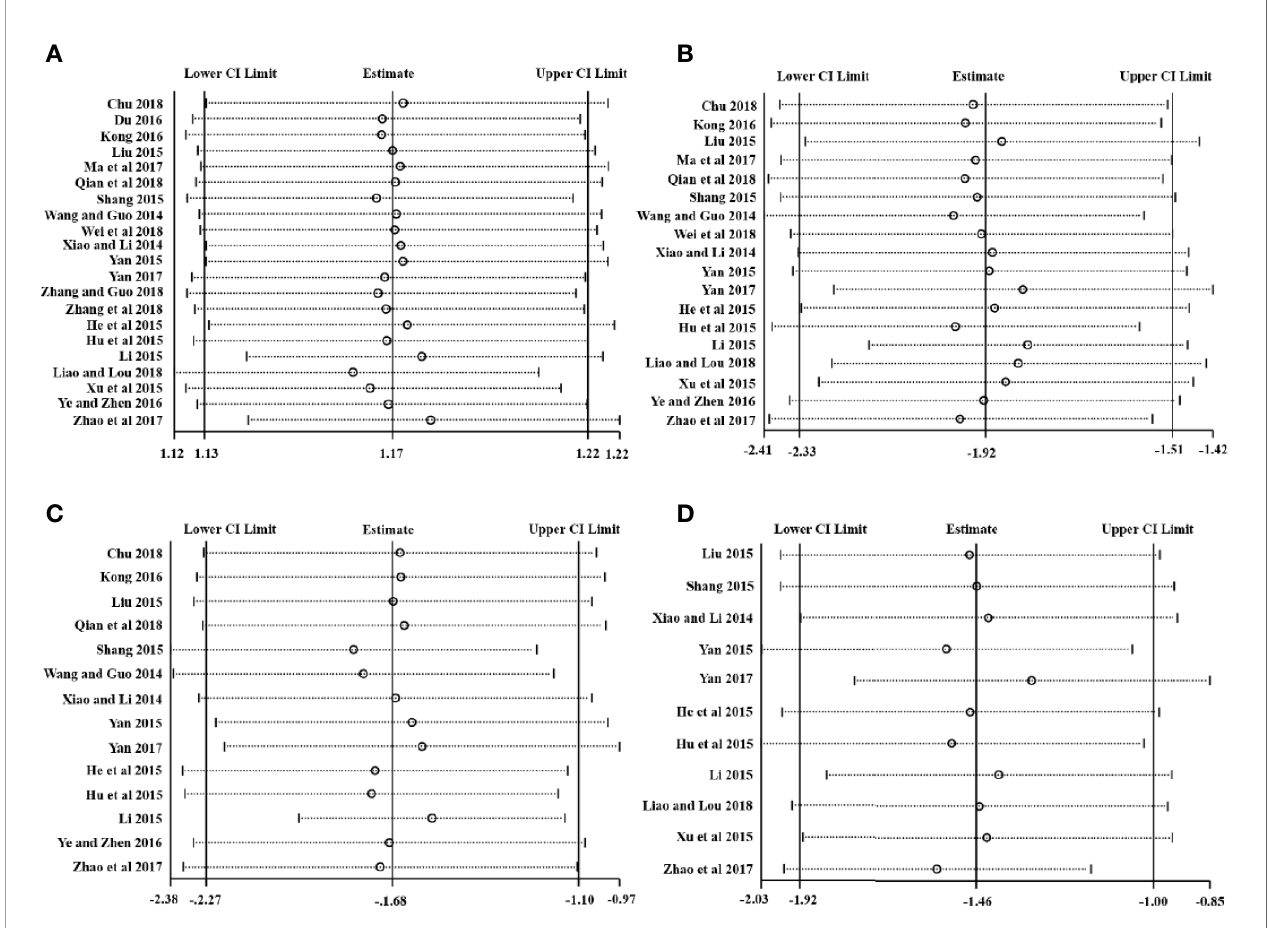
FIGURE 10 | Sensitivity analysis plots of (A) CER, (B) RTC, (C) RTR, and (D) RTF.